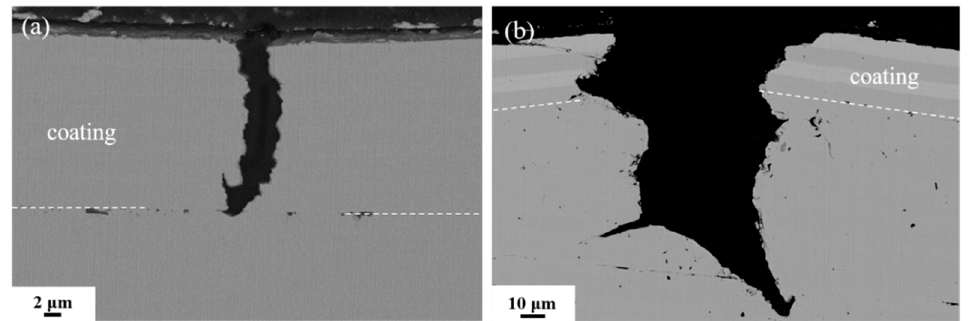
Figure 6. Longitude-sectional SEM images of the composite coating CG substrate: ( a ) Specimen with 2.5 μ m NiP/2.5 μ m Ni composite coating; ( b ) Specimen with 7.5 μ m NiP/7.5 μ m Ni composite coating.